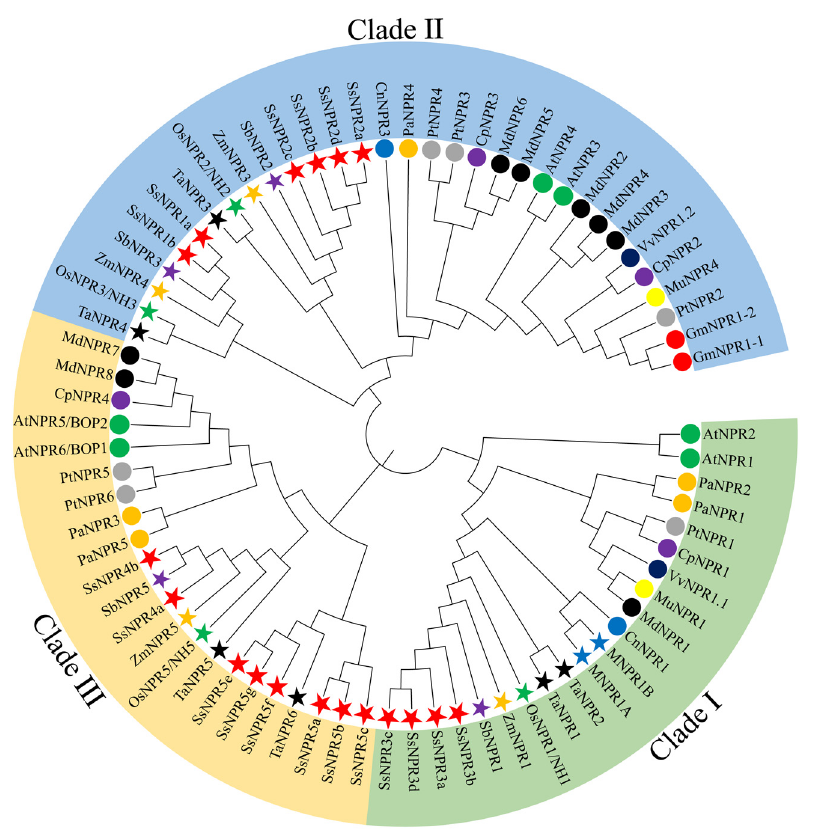
Figure 1. Phylogenetic analysis of NPR1 homologous proteins from 15 plant species. The MEGA X with the neighbor-joining method was used to conduct the phylogenetic tree. NPR1-related proteins came from five monocot species ( Musa acuminate (M), Oryza sativa (Os), Sorghum bicolor (Sb), Triticum aestivum (Ta), and Zea mays (Zm)) and nine dicot species ( Arabidopsis thaliana (At), Carica papaya (Cp), Cocos nucifera (Cn), Glycine max (Gm), Malus domestica (Md), Morus multicaulis (Mm), Persea americana (Pa), Populus trichocarpa (Pt), and Vitis vinifera (Vv)). All the GenBank accession numbers of the NPR1 homologous proteins are listed in Table S3. Three major clades are distinguished with three colors, and the NPR1 homologous proteins from different plant species are indicated by different colors of circles and stars.